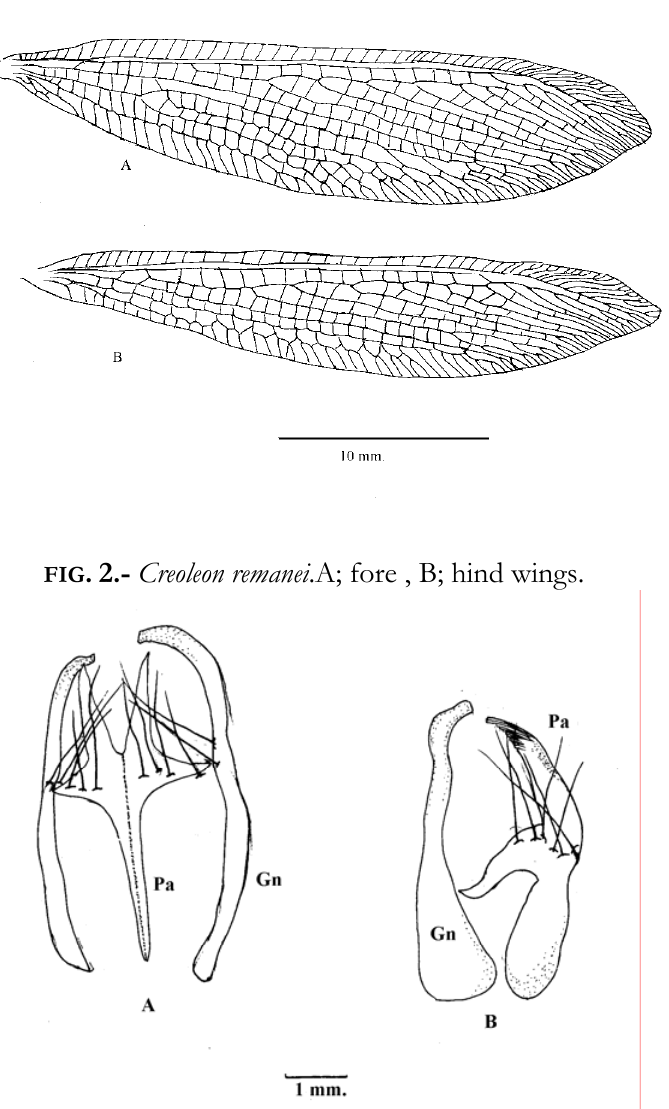
FIG . 3.- Male genitalia of Creoleon remanei . A; ventral view, B; lateral view.Gn; gonarcus, Pa;